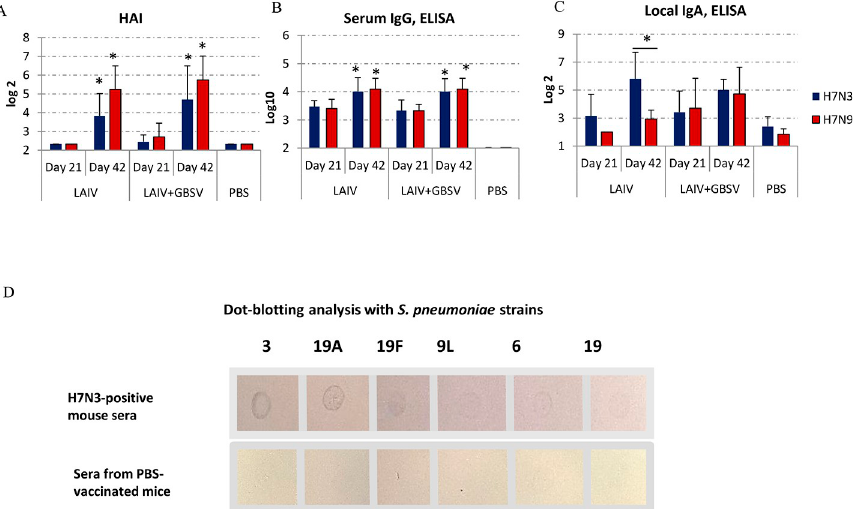
Fig 1. Immune response on day 21 and day 42 after intranasal immunization using LAIV or LAIV+GBSV (8 mice in each group, including PBS group). (A) serum HI antibodies against A/17/Mallard/Netherlands/00/95 (H7N3) and A/Shanghai/2/2013(H7N9) CDC-RG influenza viruses, � —P < 0.005 compared to day 21. (B) serum virus-specific IgG, � —P < 0.005 compared to day 21. (C) local virus-specific IgA, � —P < 0.05. (D) dot-blotting analysis of pool sera obtained after LAIV-only immunization, reacting with S . pneumoniae strains.